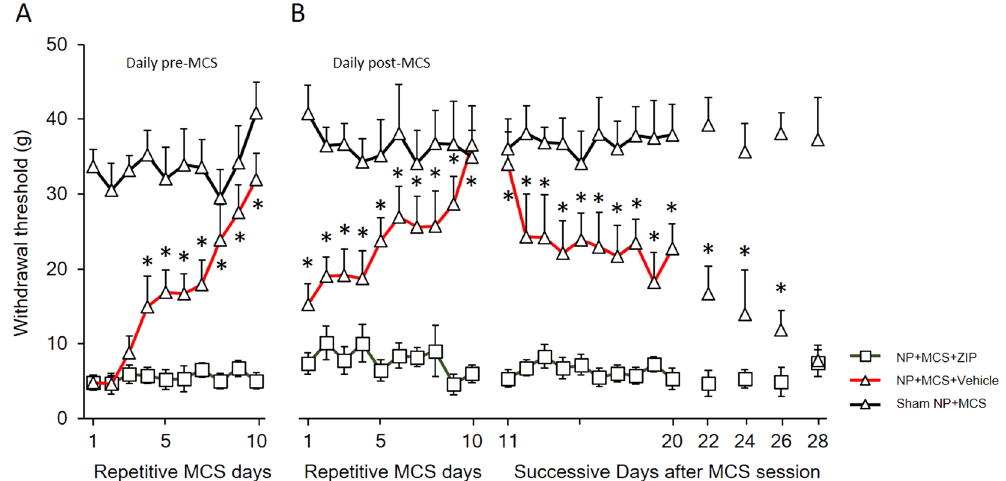
Figure 4. Long-term effects of MCS. ( A ) Comparison of the effects of daily pre-MCS in different conditions. Neuropathic pain rats with MCS show gradually increased withdrawal thresholds up to the 10 th day after MCS. ( B ) To evaluate the duration of the effects of daily post-MCS, the mechanical thresholds were measured daily until the 28 th day after MCS. The effects of MCS gradually decreased until the 17 th day after termination of